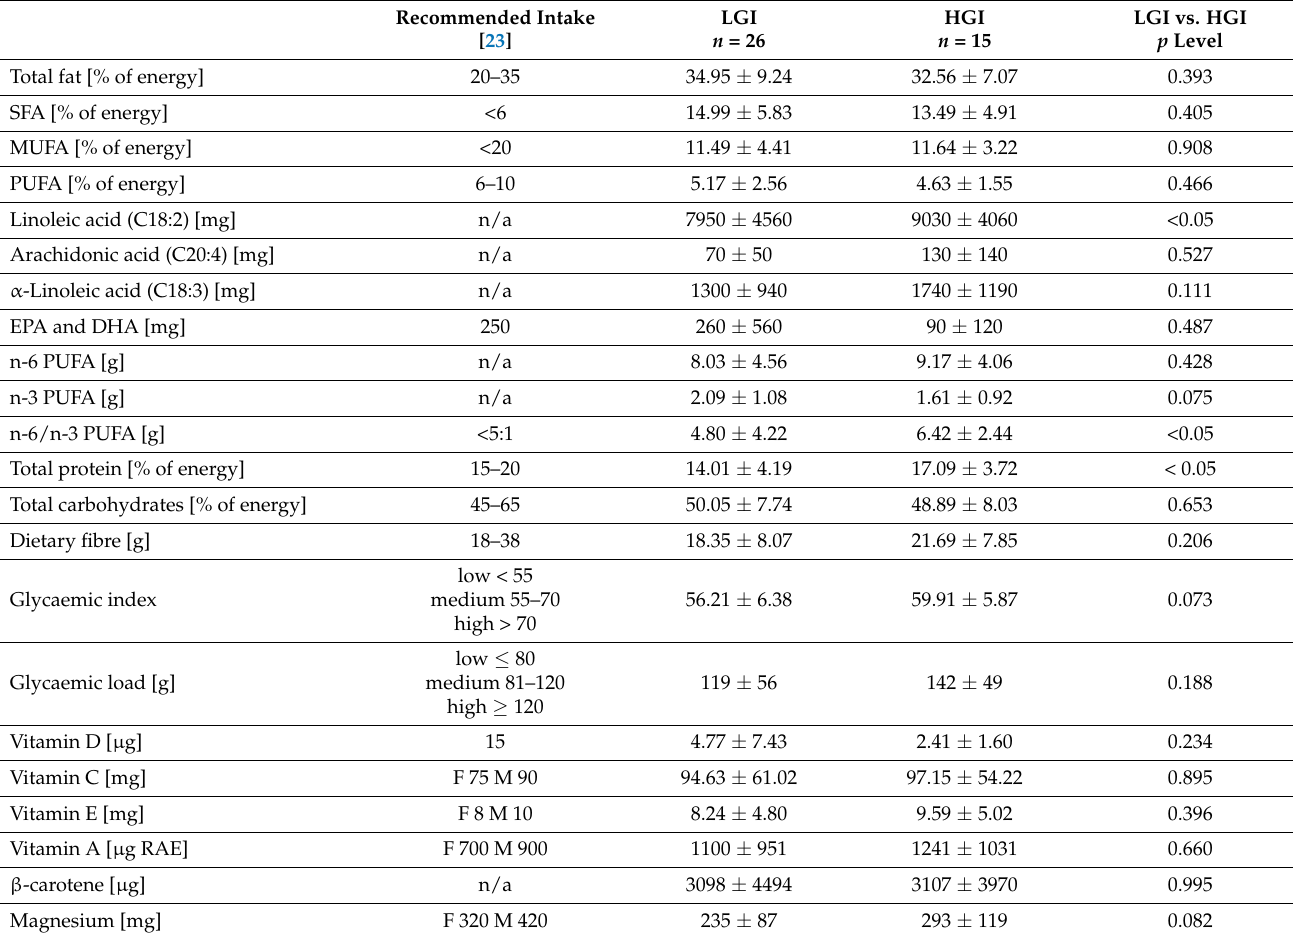
Table 3. Daily energy, vitamin and mineral intakes as well as recommended amounts for the Polish elderly population (mean ±